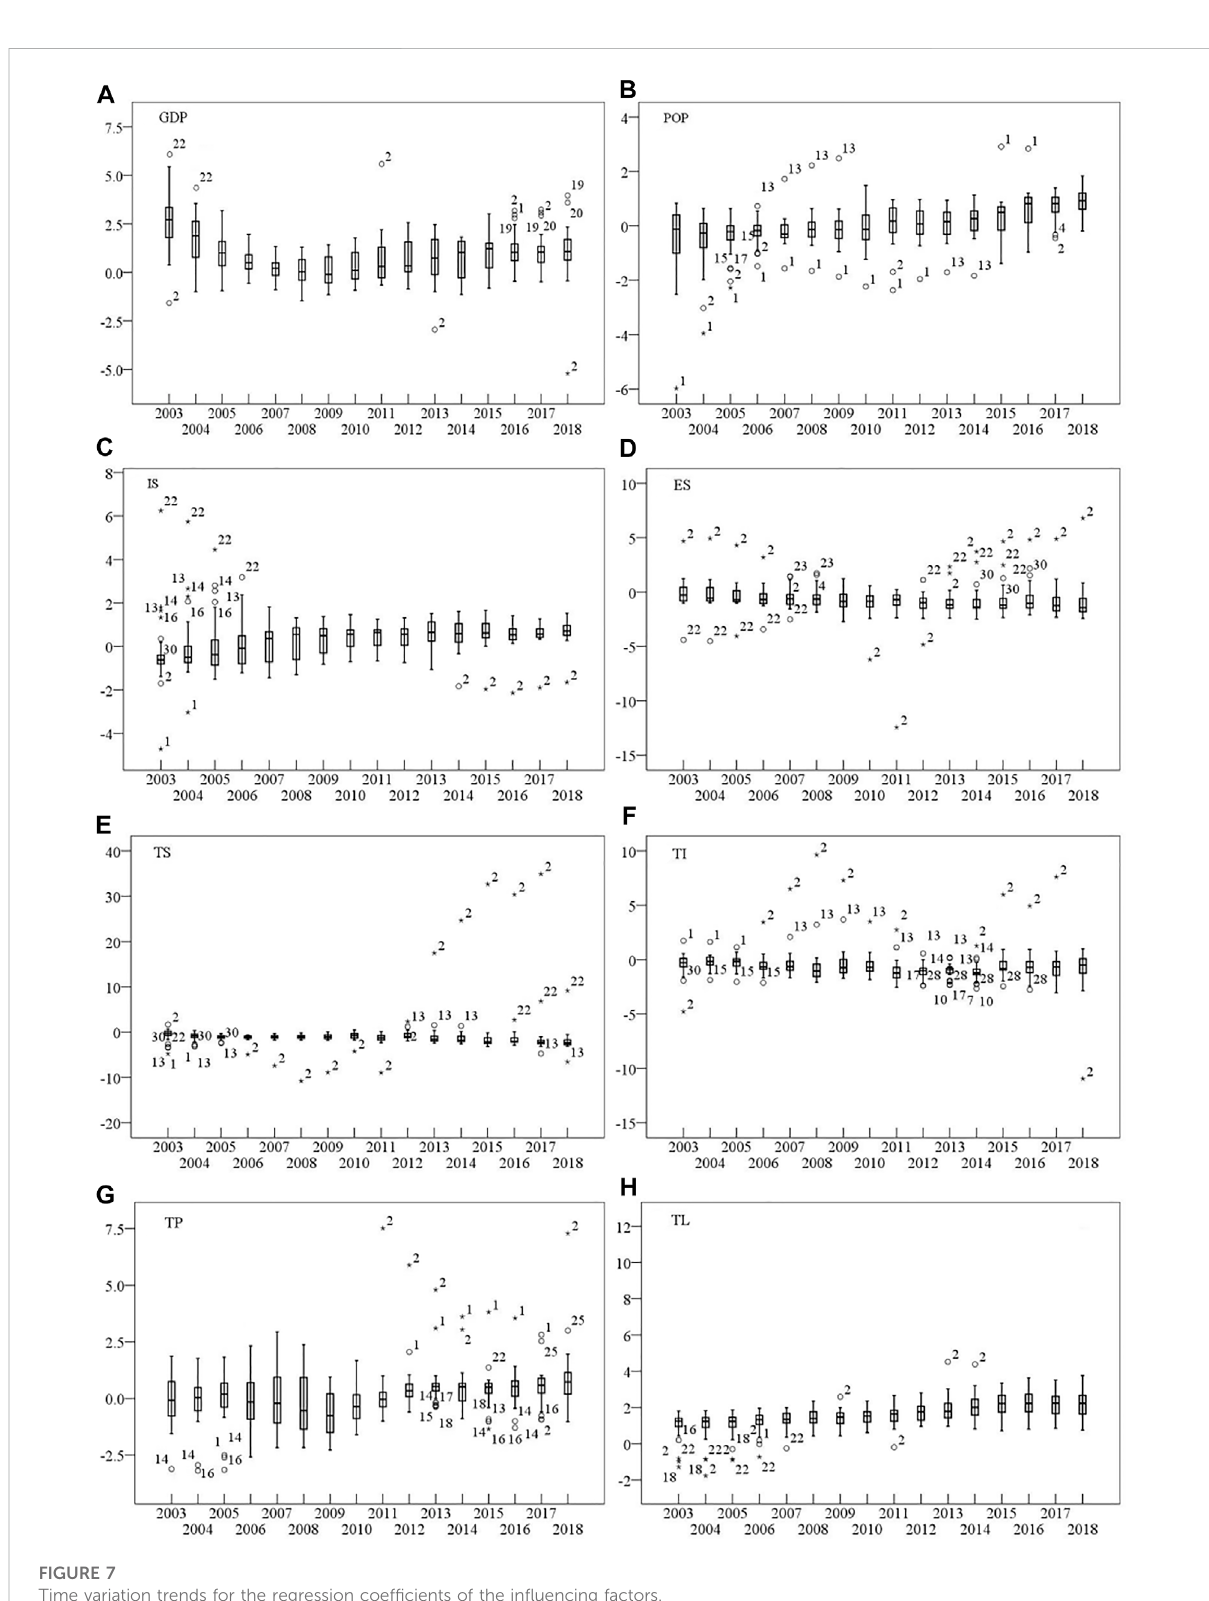
FIGURE 7 Time variation trends for the regression coef fi cients of the in fl uencing